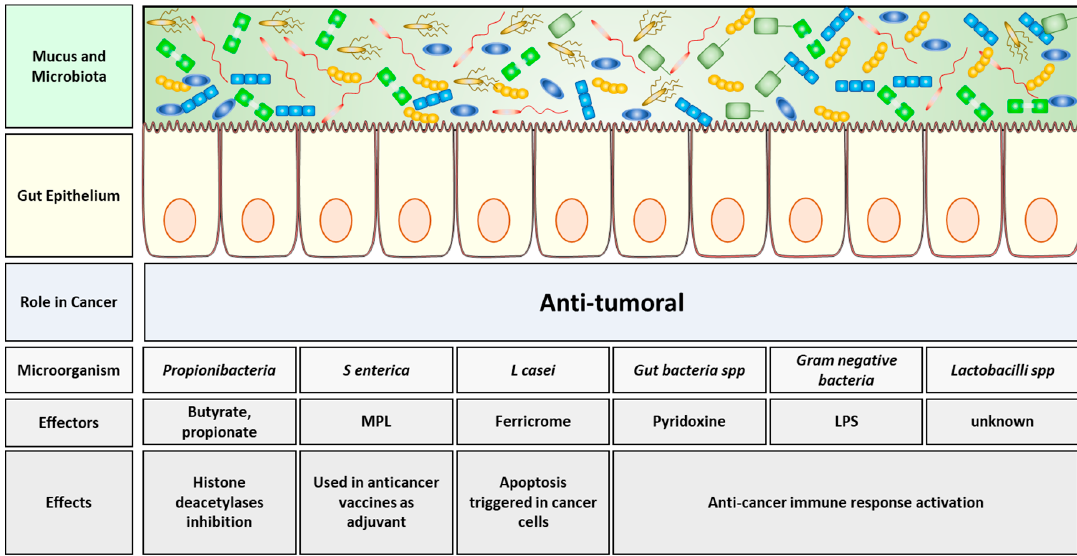
Figure 1. Anti-tumoral effects of the gut microbiota. Probiotics and other gut resident bacteria are able to secrete molecules, capable, in turn, to fight tumor growth and prevent tumorigenesis through several mechanisms. Schematic of the intestinal layers, from top to bottom: mucus and microbiota, gut epithelium. Into the grey boxes are illustrated, from top to bottom, the microorganism species implicated in the anti-cancer process, the molecules produced and the corresponding effects induced within the host. Abbreviations: MPL, monophosphoryl lipid A; LPS, lipopolysaccharide.